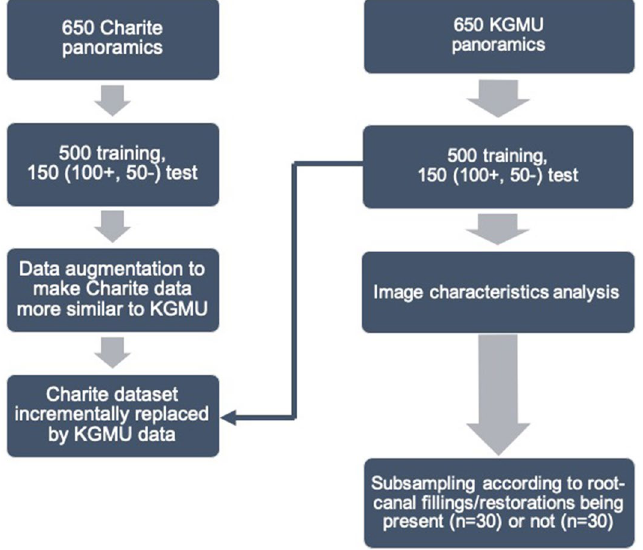
Figure 1. Flowchart of the experimental workflow. From both centers, 650 panoramic images were used to train and validate (500 images per center) and test (150 images per center, 100 with apical lesions, 50 without, respectively) models. Image characteristics were compared, the Charité training dataset augmented accordingly and then the re-trained model was tested on KGMU data. Further, models were trained on an increasingly mixed Charité-KGMU dataset and tested on KGMU data. Last, models were tested on subsamples of KGMU data consisting root-canal fillings (and other restorations) or no root-canal fillings/restorations at all.